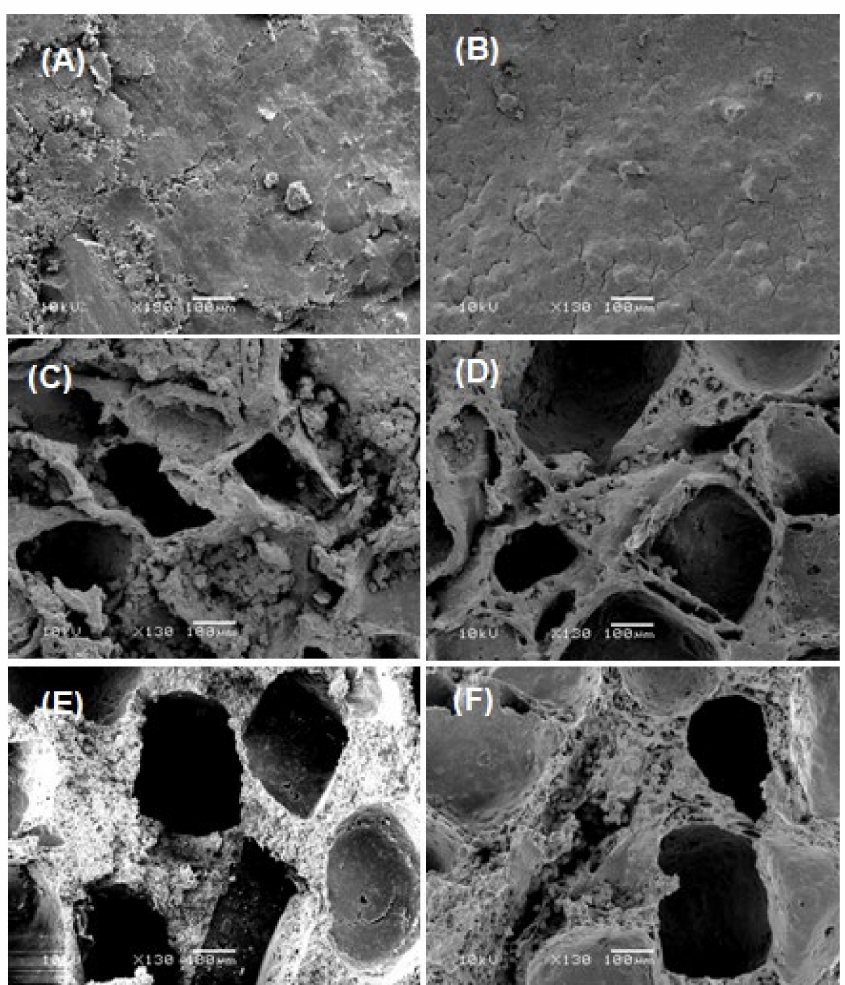
Figure 4. SEM images of surface morphologies of: ( A ) PEVAL/PDVAL/ β -TCP70 (before pore connec- tion); ( B ) PEVAL/PDVAL/ β -TCP50 (before pore connection); ( C ) PEVAL/PDVAL/ β -TCP70 (after pore connection); ( D ) PEVAL/PDVAL/ β -TCP50 (after pore connection) and cross section morpholo- gies of: ( E ) PEVAL/PDVAL/ β -TCP70 (after pore connection); ( F ) PEVAL/PDVAL/ β -TCP50 (after pore connection) zoomed at 130 ×